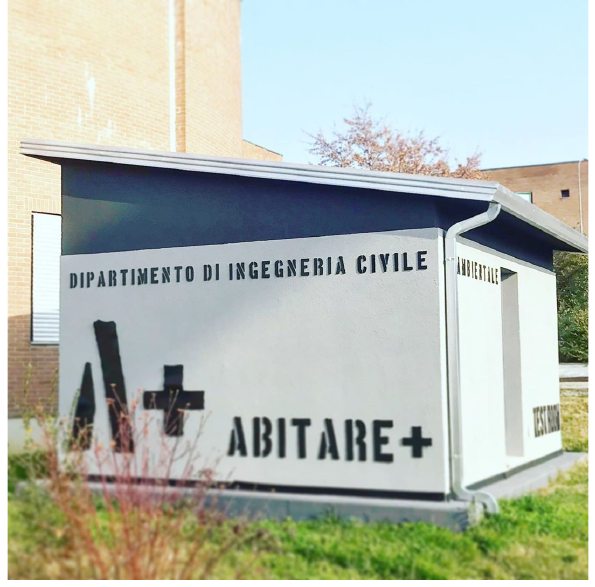
Figure 4. The completed test room.